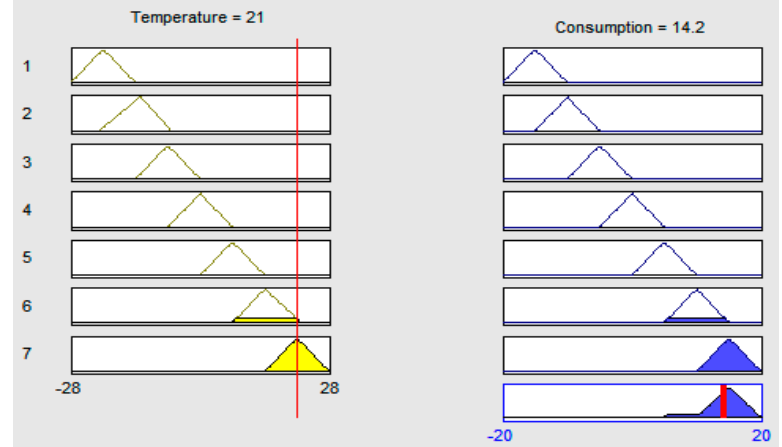
Figure 6. Applied rule for a single value based on the temperature fuzzy controller.